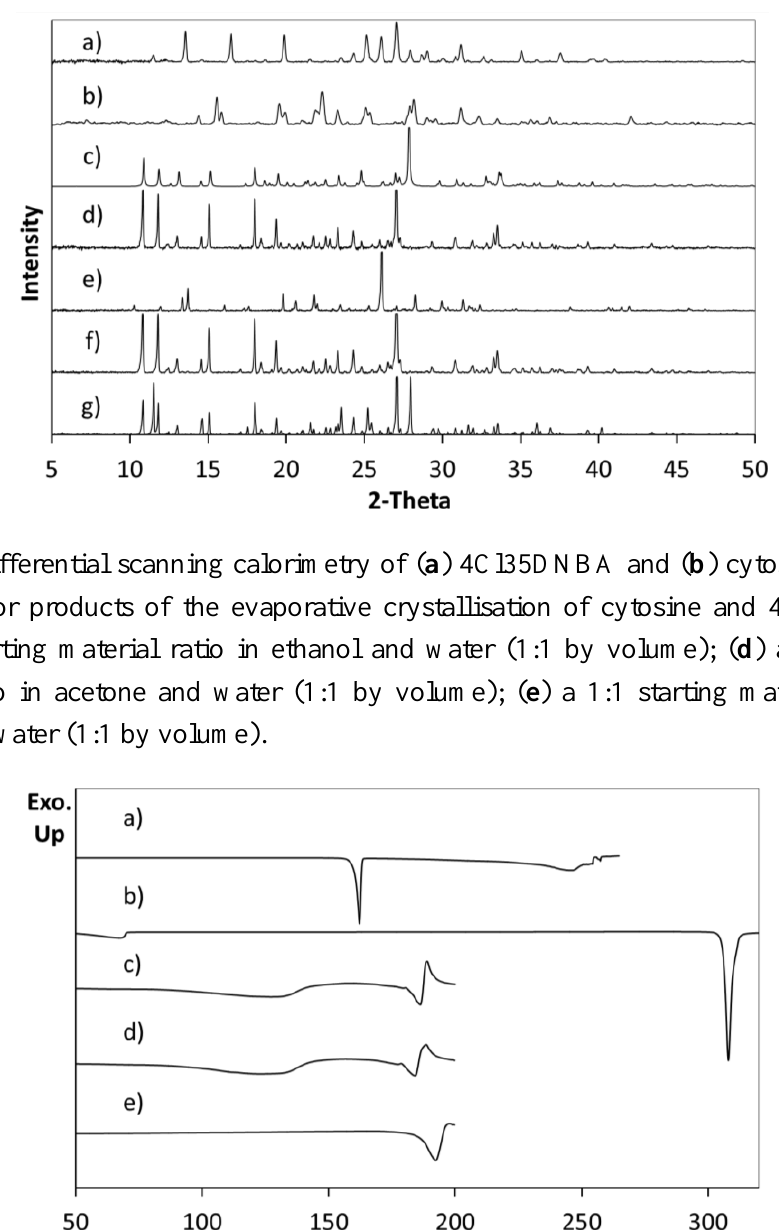
Figure 6. PXRD patterns of ( a ) cytosine; ( b ) 4Cl35DNBA and ( c ) a pattern calculated from the single crystal structure of CYT-4Cl35DNBA. These were compared with PXRD patterns of bulk products of evaporative crystallisation of cytosine and 4Cl35DNBA from different crystallisation conditions using ( d ) a 2:1 starting material ratio from ethanol and water (1:1 by volume); ( e ) a 1:1 starting material ratio from acetone and water (1:1 by volume); ( f ) a 2:1 starting material ratio in acetone and water (1:1 by volume) and ( g ) supersaturated preparation from which the single crystal used for full SXRD data was obtained.